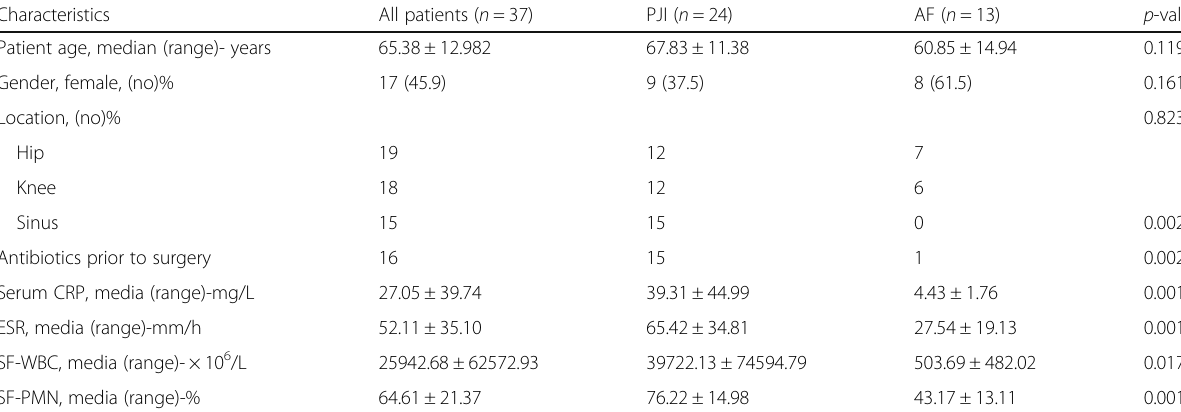
Table 1 Clinical data of included patients Characteristics All patients ( n = 37)